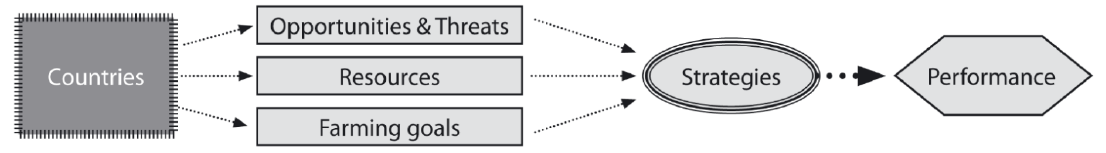
Figure 3. Framework describing the relationships of internal and external factors with strategy and farm performance, i.e., future expectations of farmers—this study.